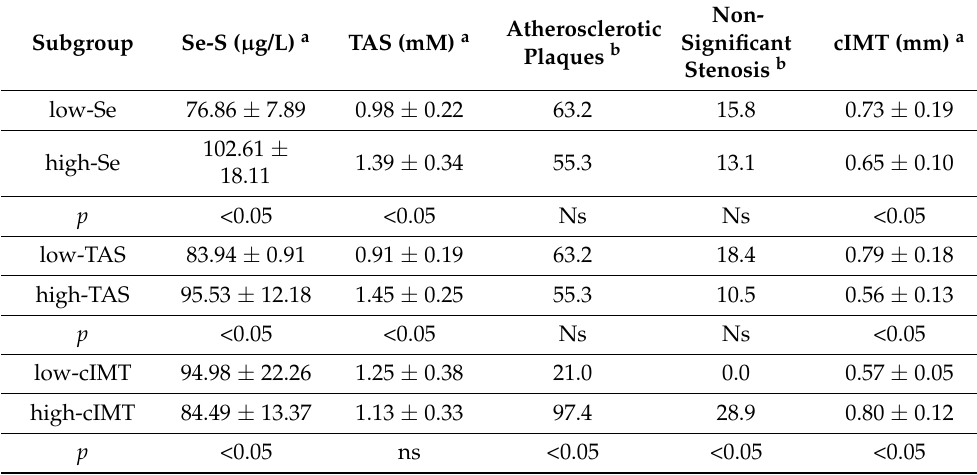
Table 2. Serum selenium concentration (Se-S), total antioxidant status (TAS), and parameters of ultrasound examination of carotid arteries in the studied subgroups of patients.